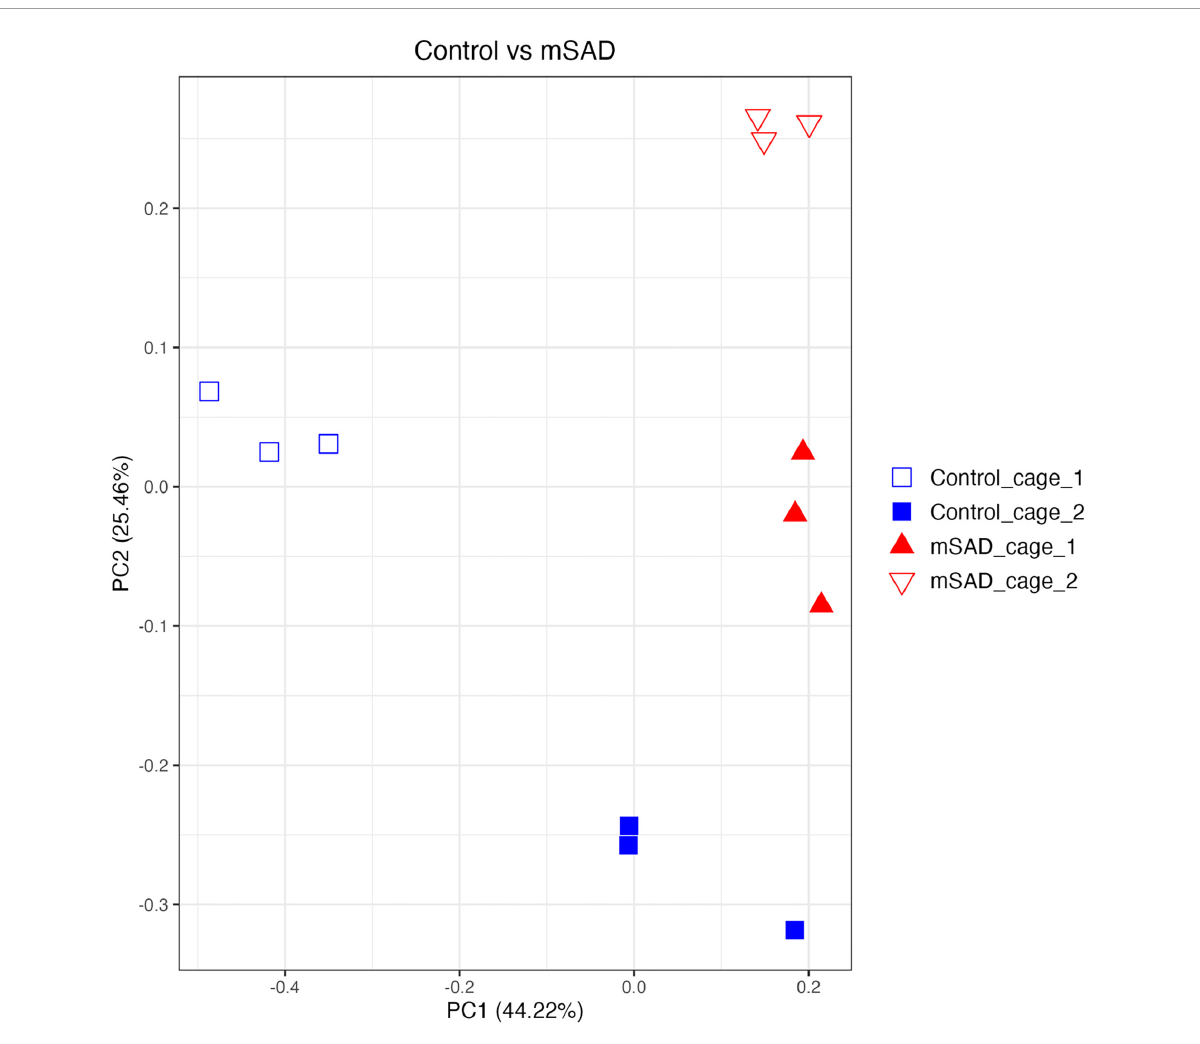
FIGURE10 Beta diversity analysis of gut microbiota of mouse samples was observed across similarity metrics determined via QIIME2 (2021.11). A Bray–Curtis PCOA plot displays sample clustering patterns based on observed ASVs. plotted with R (ggplot package), and the q2-qiime diversity beta-group-significance. The group assignments are indicated as follows: control_cage_1 (blue open square; n = 3); control_cage_2 (blue square; n = 3); mSAD_cage_1 (red triangle; n = 3); mSAD_cage_2 (red open triangle; n =